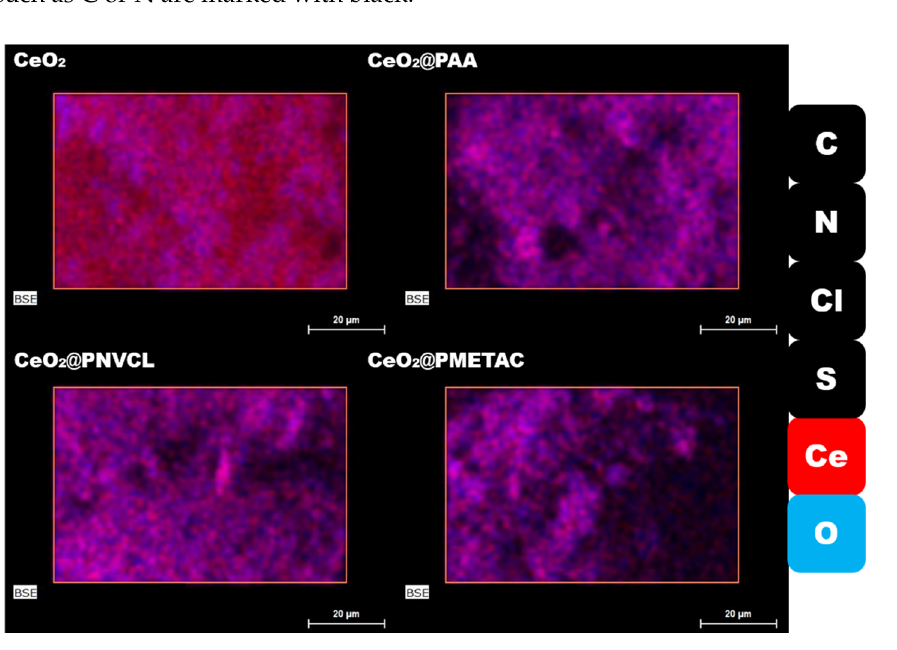
Figure 3. EDX mapping results for the initial CeO 2 nanoparticles and the ones with the different polymer brushes (C, N, Cl, and S: black; Ce: red; and O: blue).